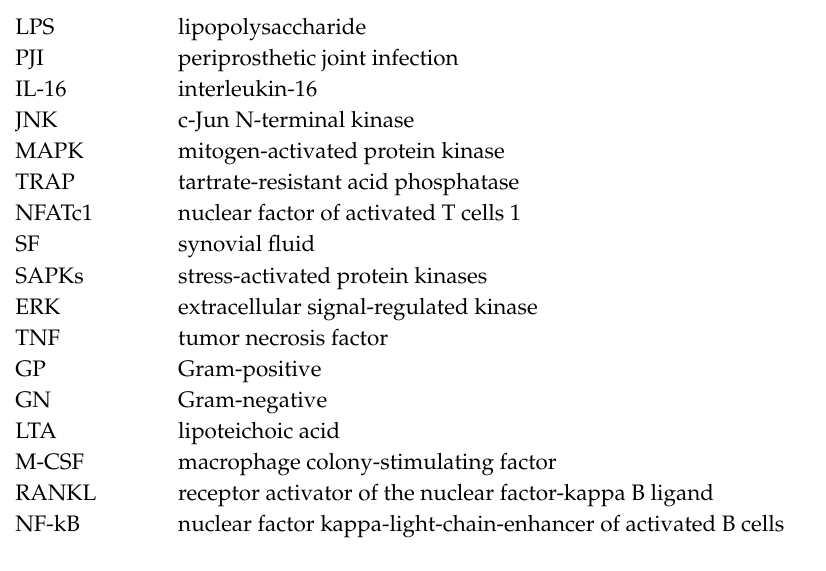
Figure S1: Interleukin-16 (IL-16) did not change the receptor activator of nuclear factor-kappa B ligand (RANKL)-induced di ff erentiation of RAW264.7 cells into osteoclast-like cells. Figure S2: Interleukin (IL)-16 did not change extracellular signal-regulated kinase (ERK) mitogen-activated protein kinase (MAPK) signaling during osteoclast